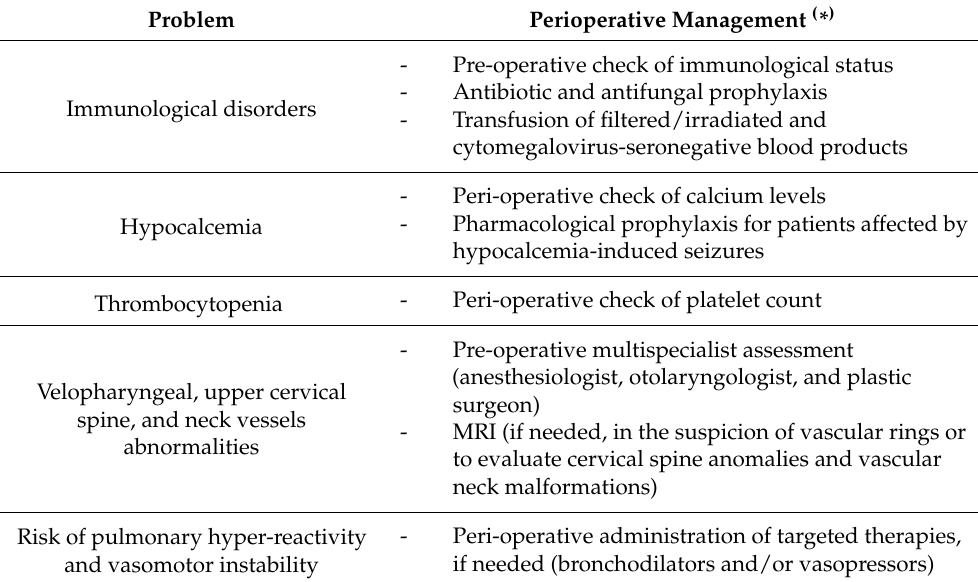
Table 2. Perioperative management of 22q11.2DS